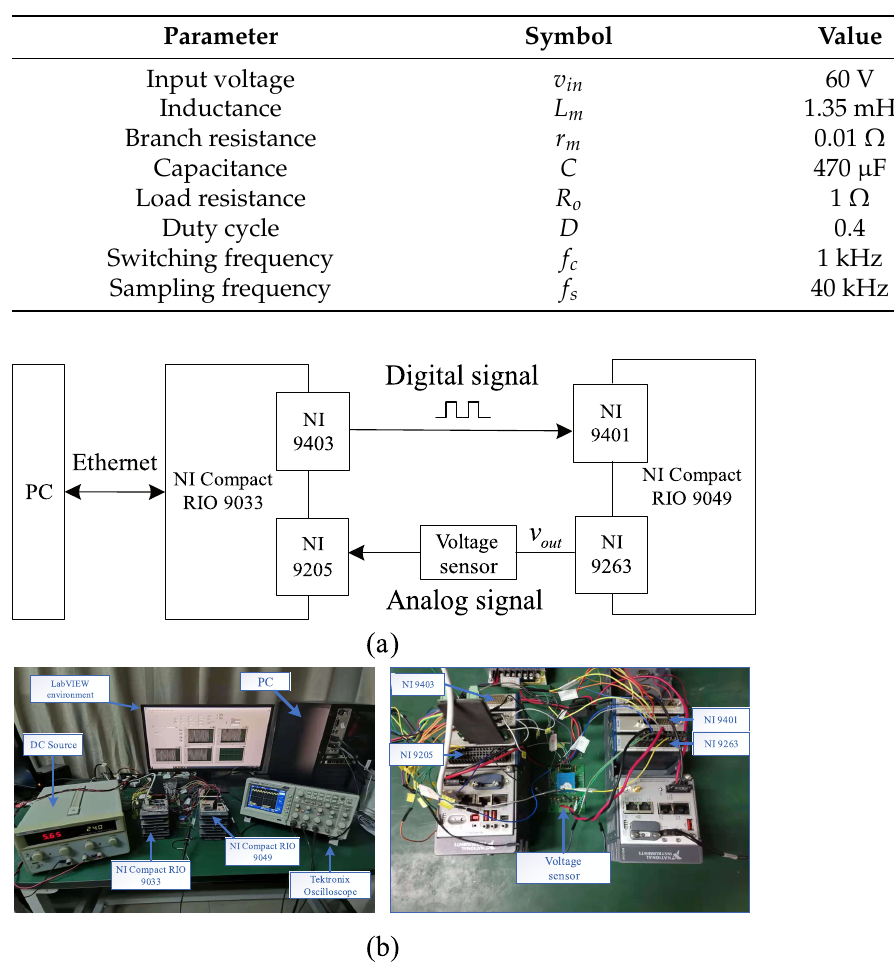
Table 2. The system and control parameters.